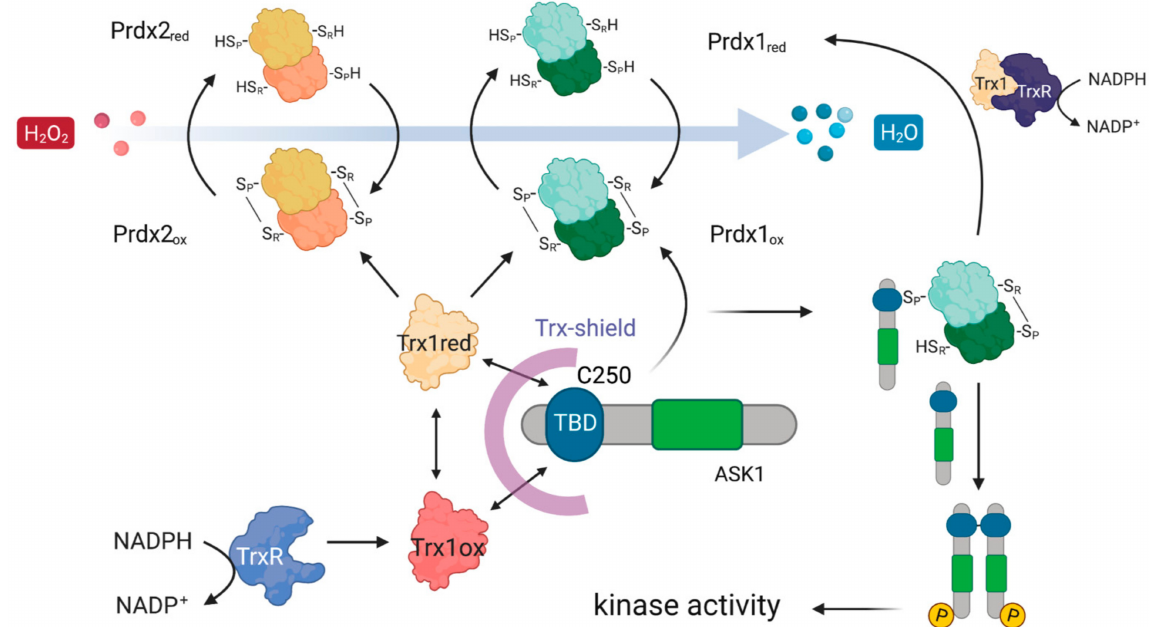
Figure 7. Possible mechanistic model of how Prdx1 and Prdx2 could interact with ASK1. The ASK1-TBD harboring the critical C250 is protected by a Trx-shield. This shield consists of Trx1 which is constantly being recycled from oxidized to reduced Trx1 using electrons from NADPH via TrxR. Upon an increase in H 2 O 2 , Prdx1 and Prdx2 get oxidized and then oxidize Trx1 bound to the ASK1-TBD. As oxidized Trx1 binds the ASK1-TBD with a lower affinity [32], it allows oxidized Prdx1 to outcompete it for binding to the ASK1-TBD, enabling a nucleophilic attack of C250 on the C P -C R of Prdx1. Oxidation of ASK1 at C250 leads to ASK1 dimerization and an activation of its kinase